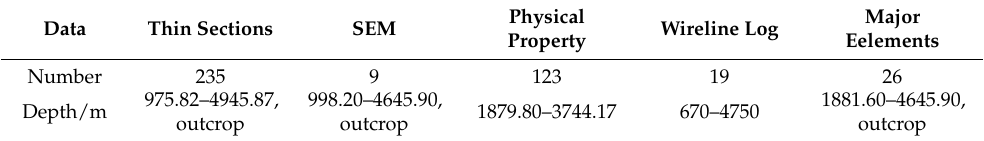
Table 1. Summary of the dataset from the Qaidam Basin in this